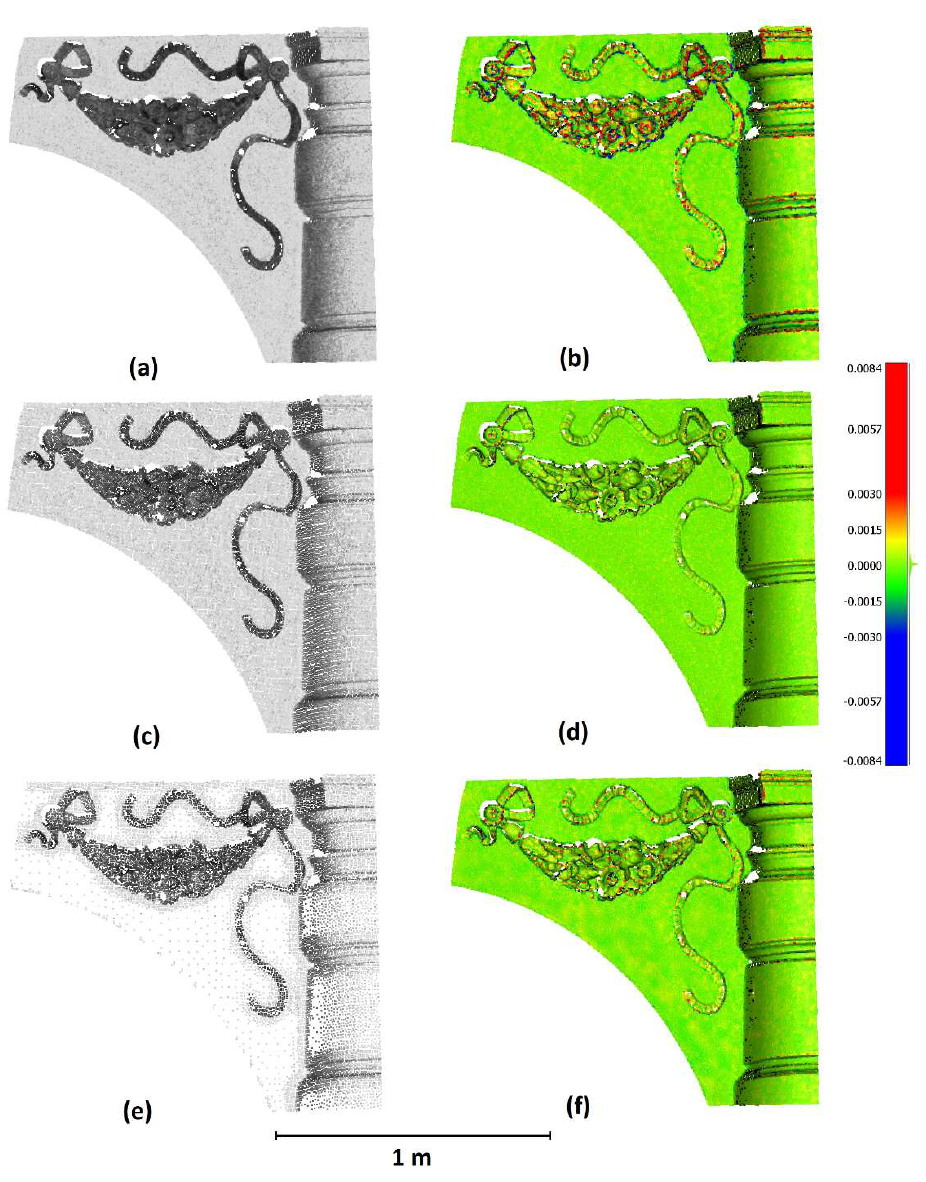
Figure 12. Details of the Data 3 point cloud: ( a ) original cloud, ( b ) differences between the cloud acquired by uniform dilution with a = 0.01 m and the original point cloud, ( c ) point cloud after uniform dilution with a = 0.005, ( d ) differences between the cloud acquired by uniform dilution with a = 0.005 m and the original point cloud, ( e ) point cloud after a = 0.005 m b = 0.05 m progressive dilution, ( f ) differences between the cloud acquired by progressive dilution with a = 0.005 m b = 0.05 m and the original point cloud. Table 4. Results of dilution of the Data 3 cloud—numbers of points and RMSDs (R = 0.05 m).